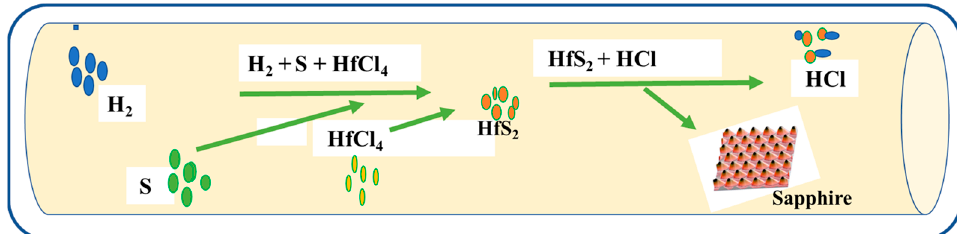
Figure 7. Schematic illustration of synthesis of HfS 2 using CVD method.